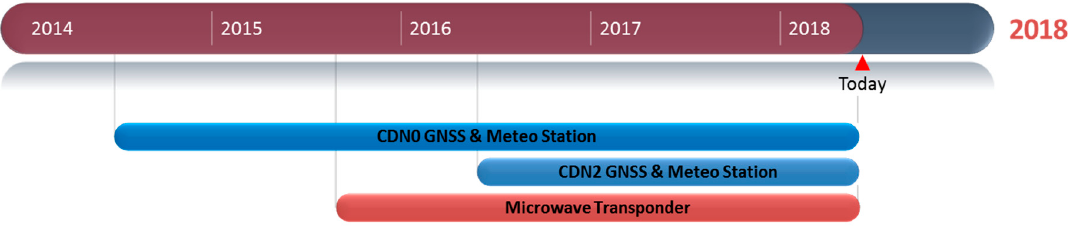
Figure 3. The operational status of the main instrumentation (microwave transponder, Global Navigation Satellite System (GNSS) receivers and meteorological stations) at the CDN1 transponder Cal/Val site as of 2014.